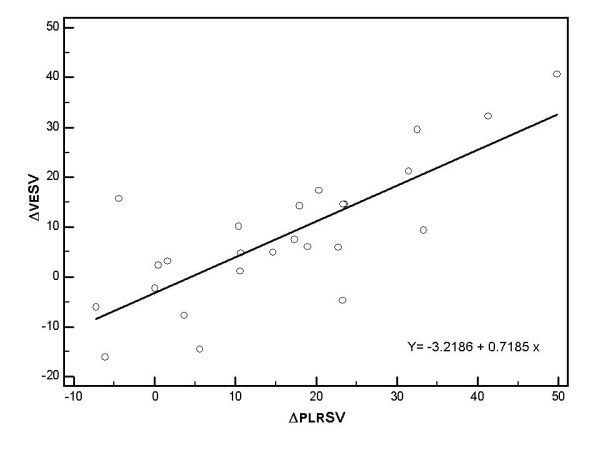
Relation between changes in stroke volume induced by PLR (ΔPLRSV) and changes in stroke volume induced by volume expansion (ΔVESV).